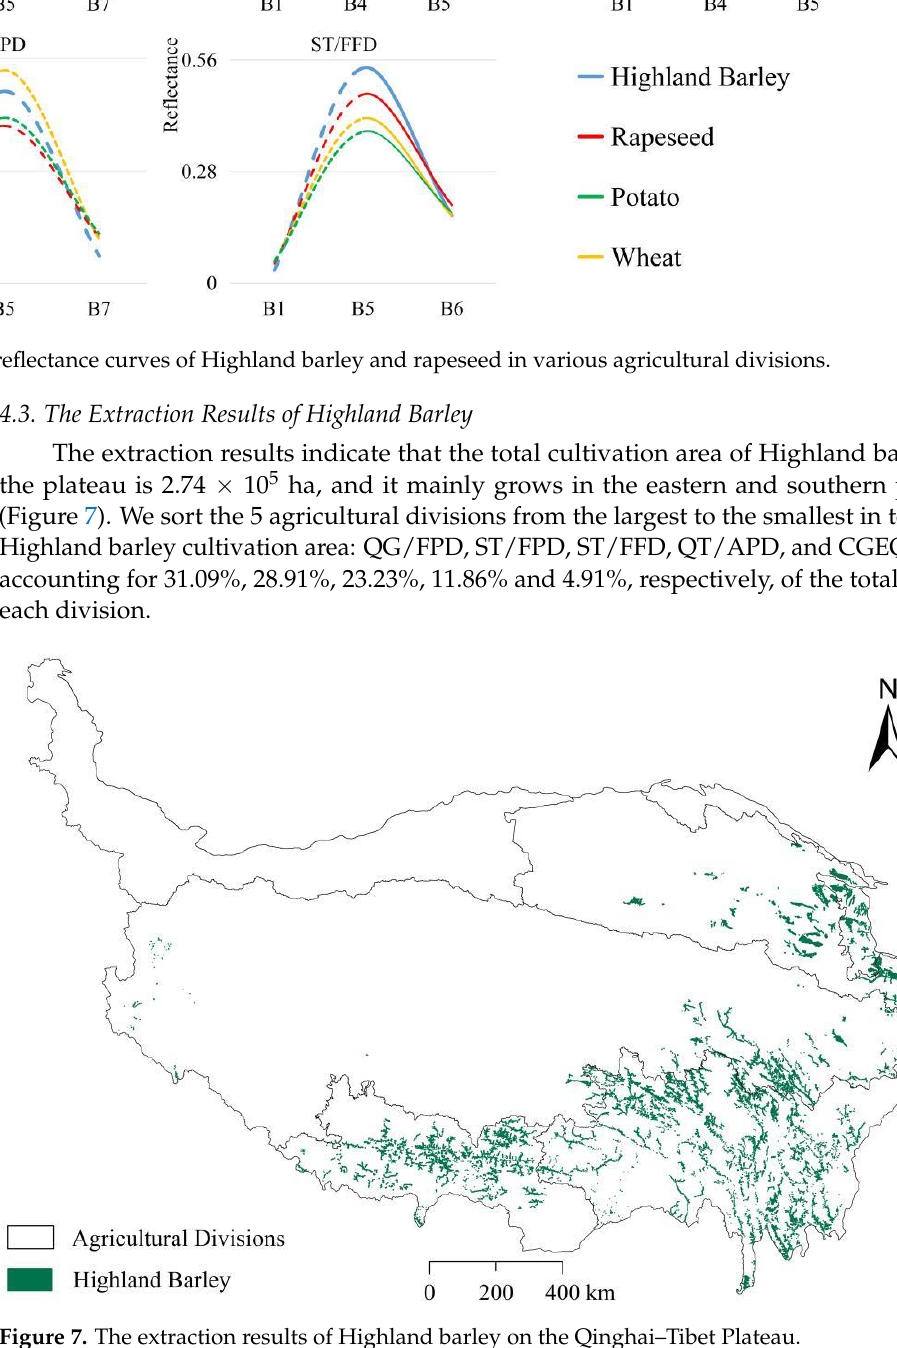
Figure 7. The extraction results of Highland barley on the Qinghai–Tibet Plateau.